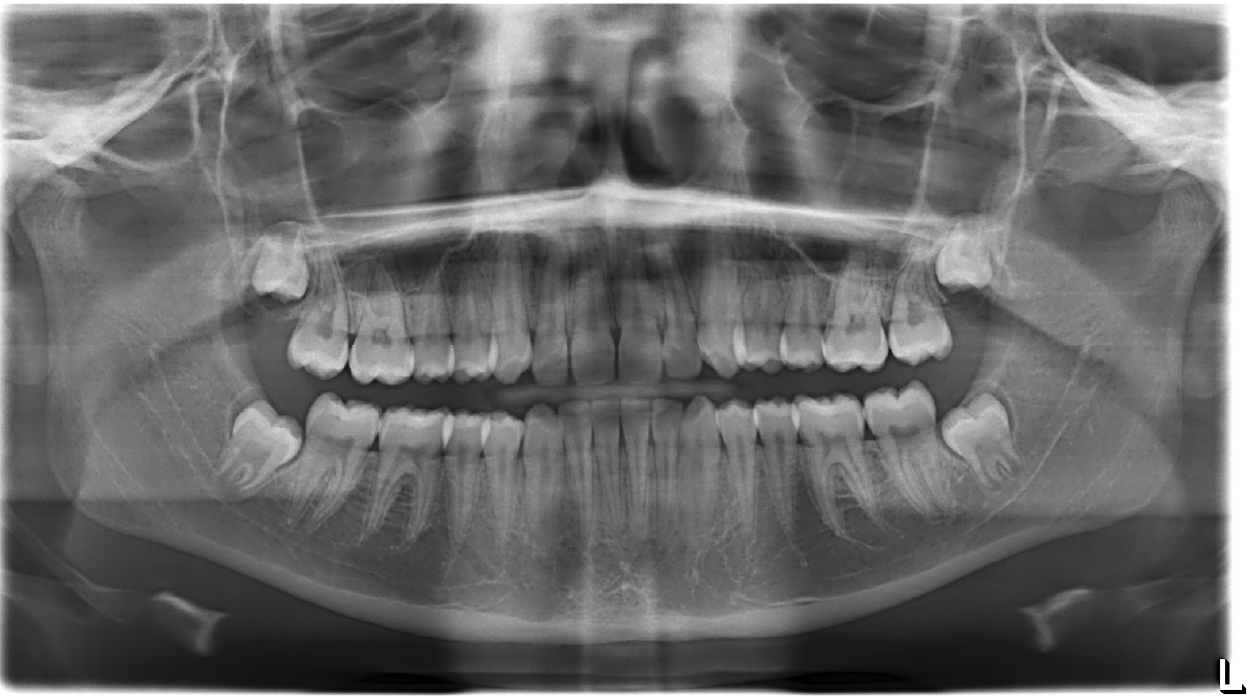
Figure 9. Final occlusal photos of dental arches (14-year-old). ( A ) Upper arch; ( B ) lower arch.